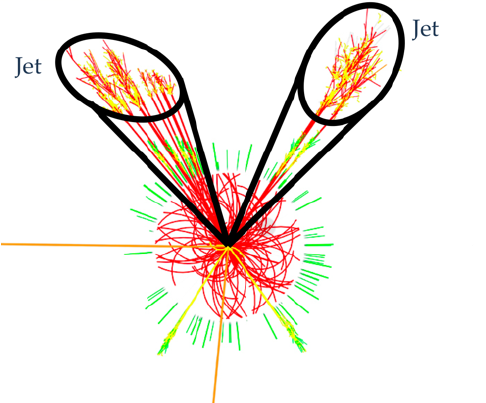
Figure 1. A schematic view of jet created in a heavy-ion collision